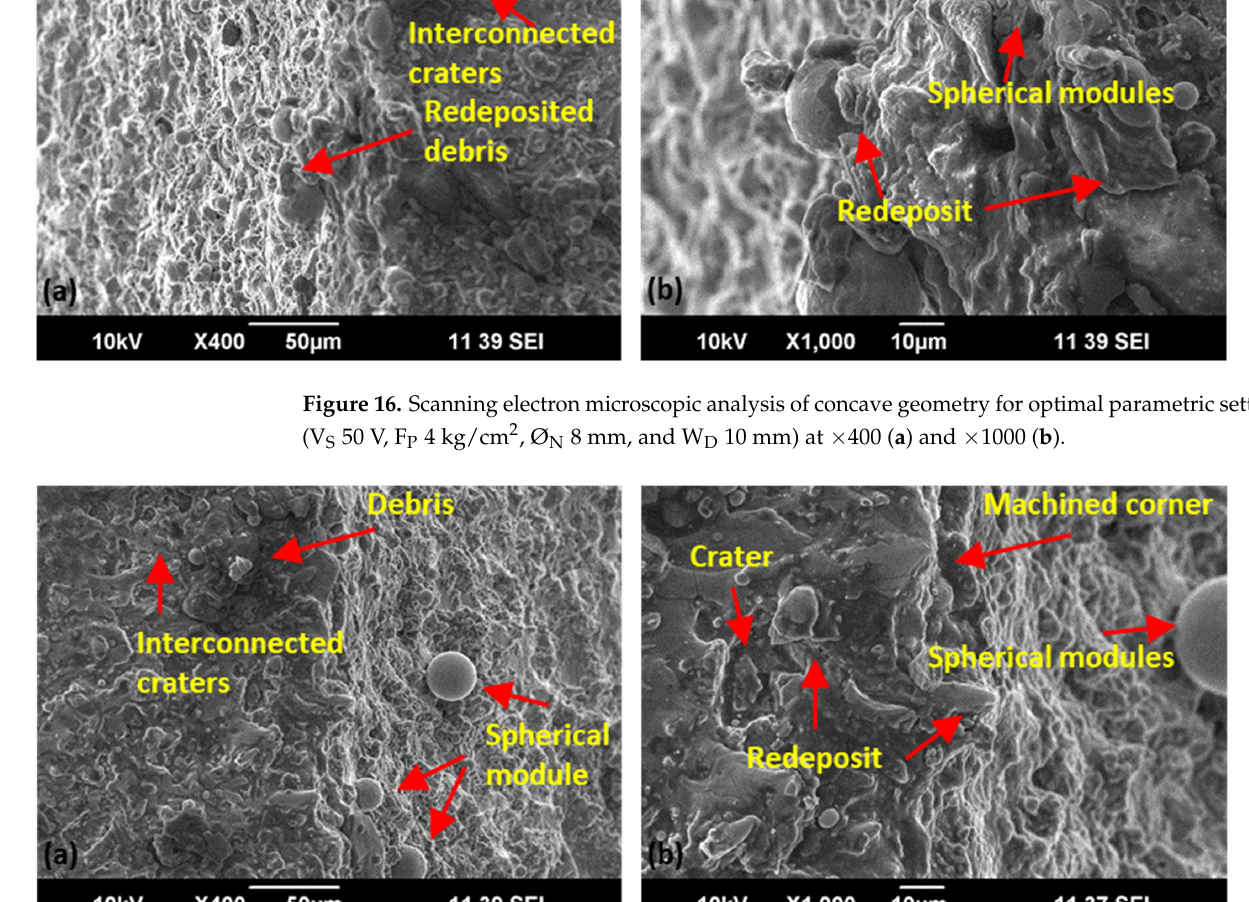
Figure 17. Scanning electron microscopic analysis of convex geometry for optimal parametric set- ting (V S 50 V, F P 4 kg/cm 2 , Ø N 8 mm, and W D 10 mm) at X400 ( a ) and X1000 ( b